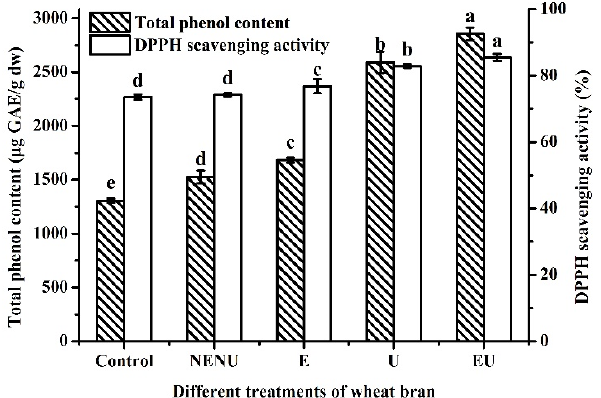
Figure 4. Effect of different treatments on TPC and AA of Jizi439 BWB. Control, white wheat bran (without extrusion and UAE); NENU, raw black wheat bran (without extrusion and UAE); E, extruded but without UAE black wheat bran; U, UAE but without extruded black wheat bran; EU, extruded, and UAE black wheat bran. ( a – e ) Indicate a significant difference between different groups (n = 3; p < 0.05).